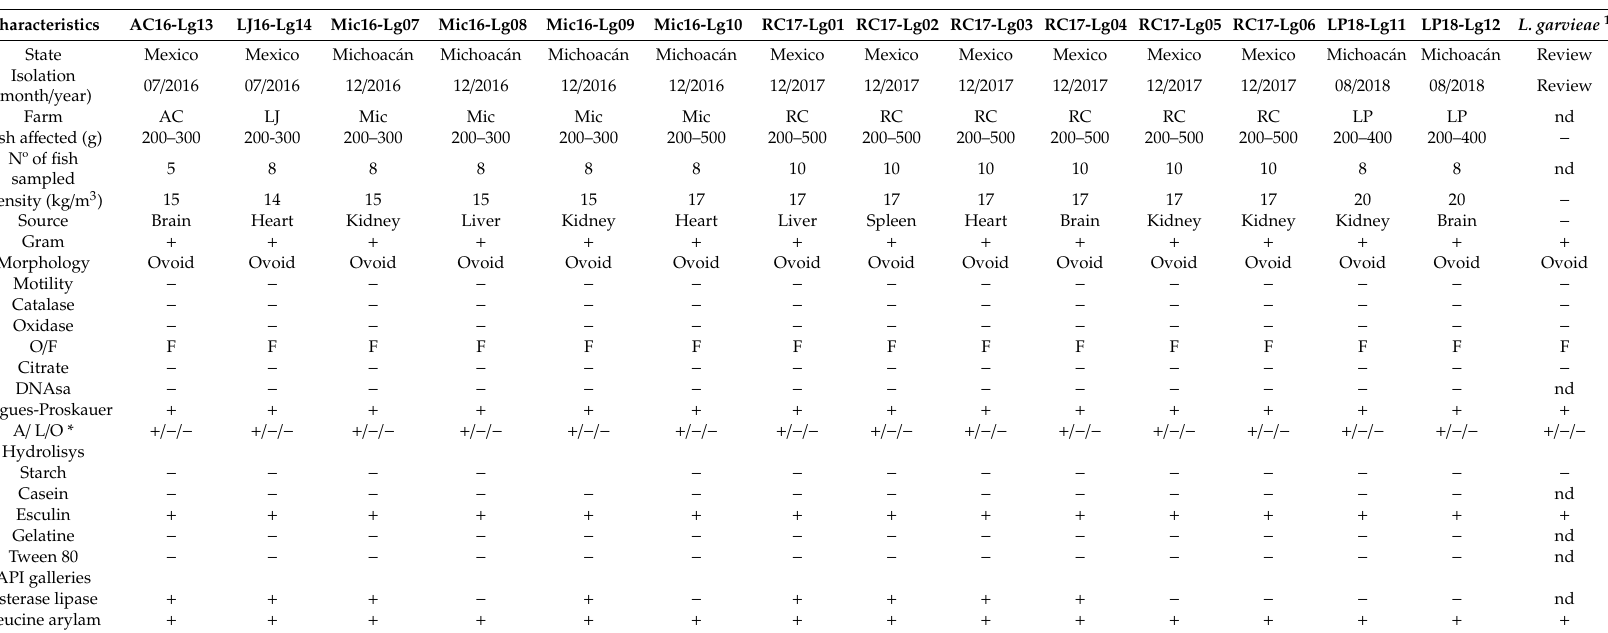
Table 1. Results obtained for the 14 Mexican rainbow trout isolates compared to the Lactococcus garvieae . Data were obtained in this study unless elsewhere mentioned. + , positive; − , negative; F, fermentation; w, weakly positive; v, variable results between API 50CH and rapid ID32 Strep; nd, not determined; * A / L / O, arginine dihydrolase and lysine and ornithine decarboxylase; 1, data obtained from Vendrell et al. [5]; 2, Ravelo et al. [14]; 3, Vela et al. [15]; β -NAG, n-acetyl- β